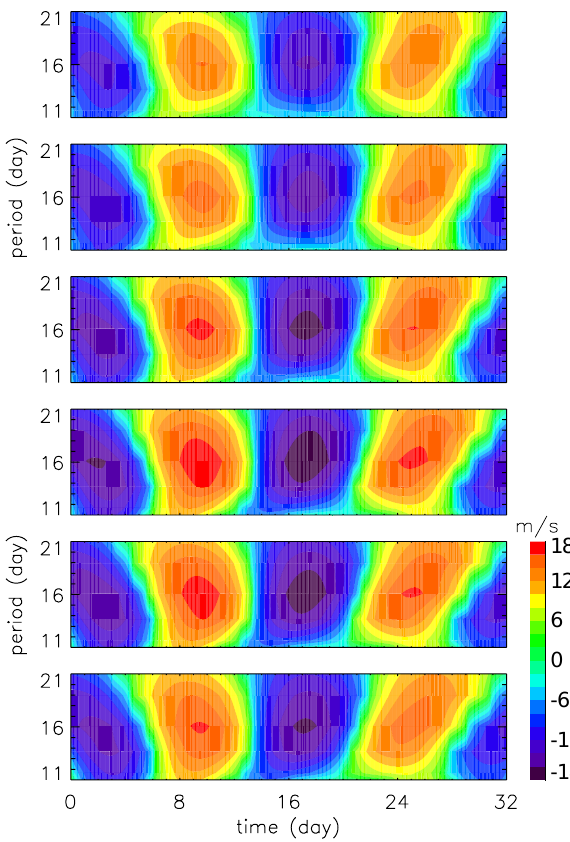
Fig. 2. 16-day wave perturbations derived from the wavelet analysis. The panels from bottom to top represent the results at 90–95km.